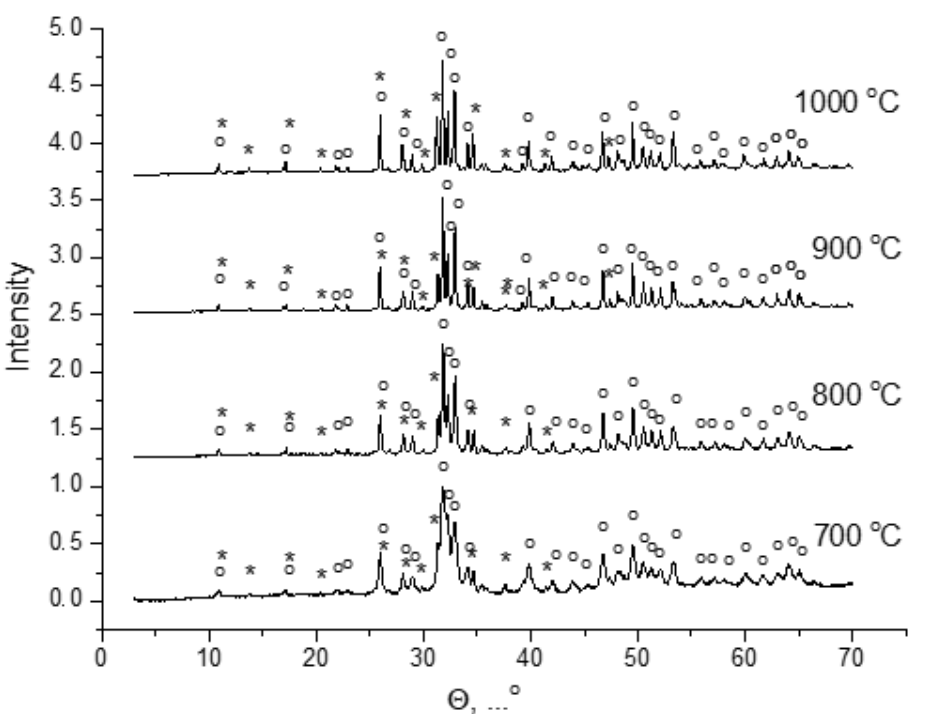
Figure 8. XRD data of powders enriched with inorganic components prepared from the fish scale mixture using high-speed grinding and vibration sieving after heat treatment in the interval of 700 ◦ C–1000 ◦ C: o—Ca 10 (PO 4 ) 6 (OH) 2 (PDF card #9-432; *—Ca 2.81 Mg 0.19 (PO 4 ) 2 (PDF card #70-682) or Ca 18 Mg 2 H 2 (PO 4 ) 14 (PDF card #70-2064).